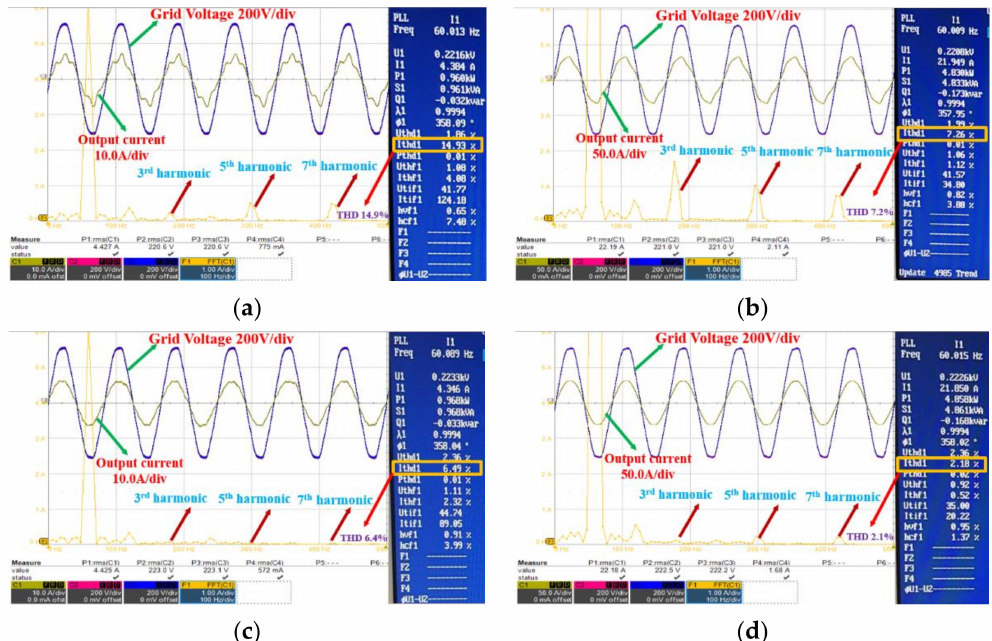
Figure 13. Experimental results of GCI ( a ) without harmonic compensation at 1 kW, ( b ) without harmonic compensation at 5 kW, ( c ) proposed LIA harmonic compensation at 1 kW, ( d ) proposed LIA harmonic compensation at 5 kW.